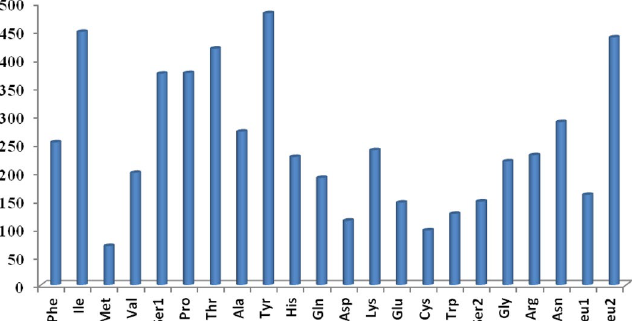
Figure 5. Relative synonymous codon usage (RSCU) of the mitochondrial protein-coding genes of U. thibetanus laniger mitochondrial genome. Codon count numbers are provided on x-axis and amino acids on